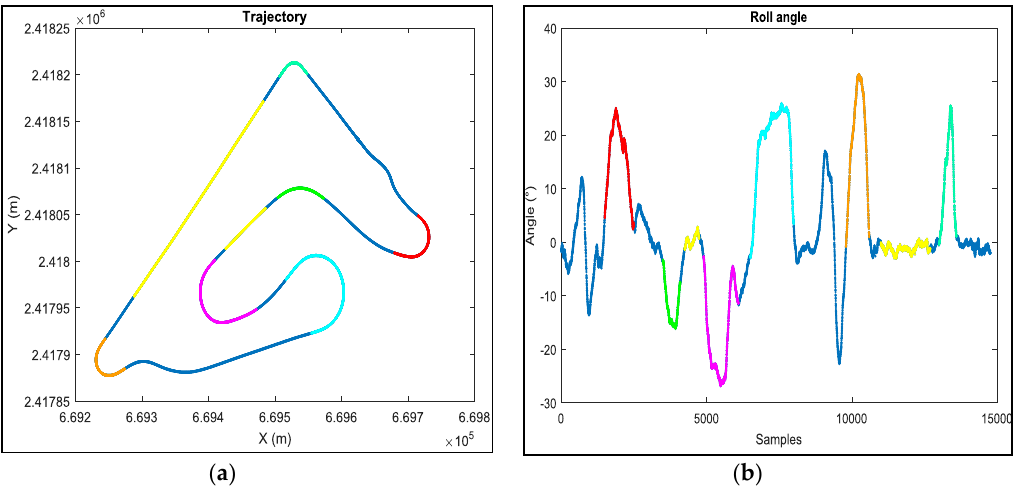
Figure 7. Difference between the real traveled distance and the one given by the odometers using a fixed wheel radius ( a ) and our proposed wheel radius model ( b ).